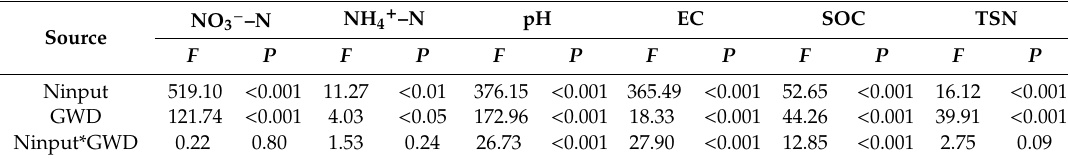
Table 1. E ff ects of depression of groundwater table, reduced nitrogen application and their interactions on soil